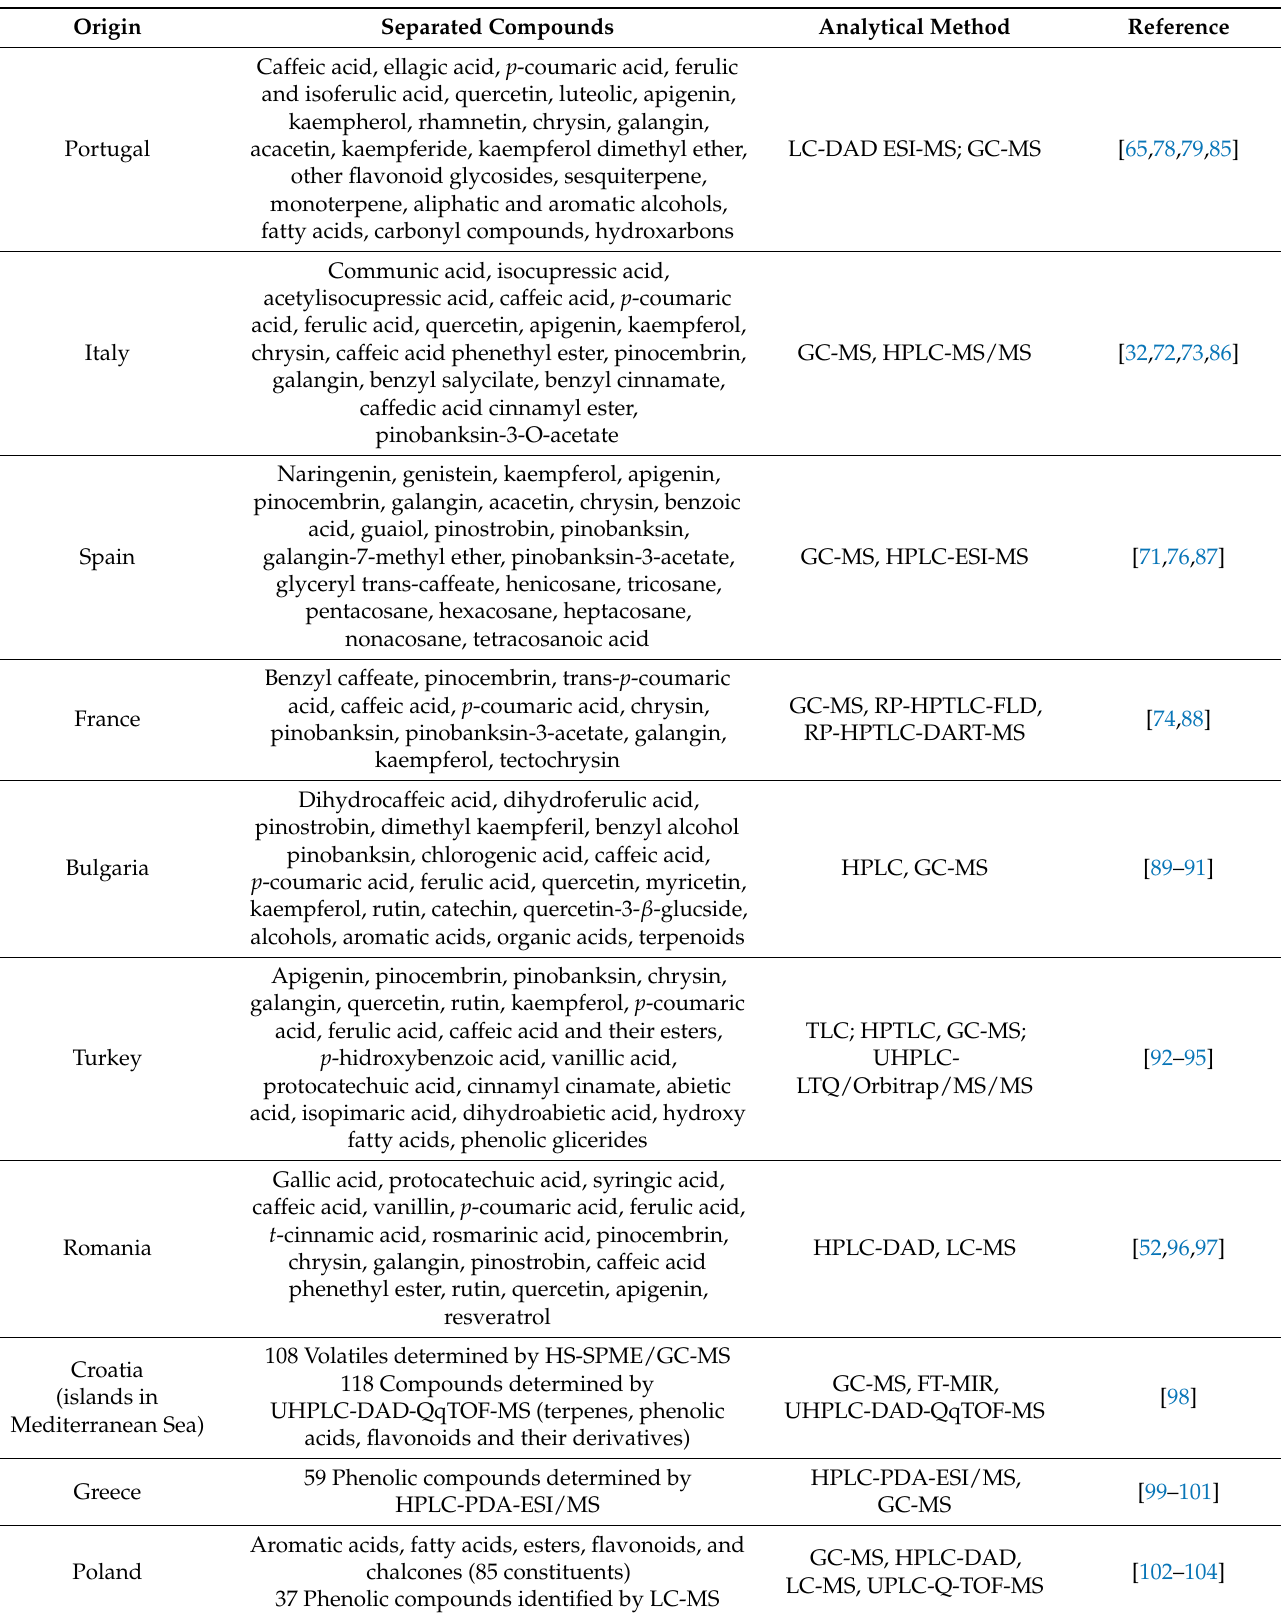
Table 2. Chemical composition of poplar-type propolis of the major producing poplar-type propolis of the world. Origin Separated Compounds Analytical Method